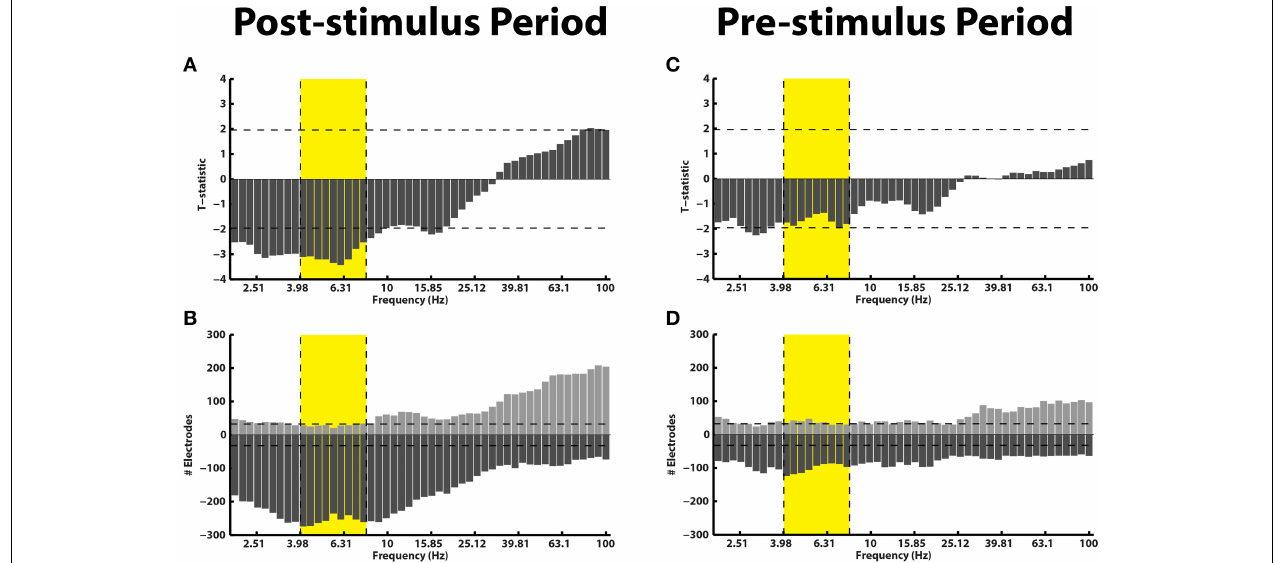
FIGURE 2 | Subsequent memory effect pre- and post-stimulus. (A) Across all patients, t -statistics (y-axis) comparing spectral power during the presentation of items that were later recalled vs. those that were later not-recalled are plotted for all frequencies (x-axis) for the post-stimulus interval (300–1500ms after word onset). A positive t -statistic represents more power in the recalled vs. the not-recalled condition across all 14 patients. The yellow